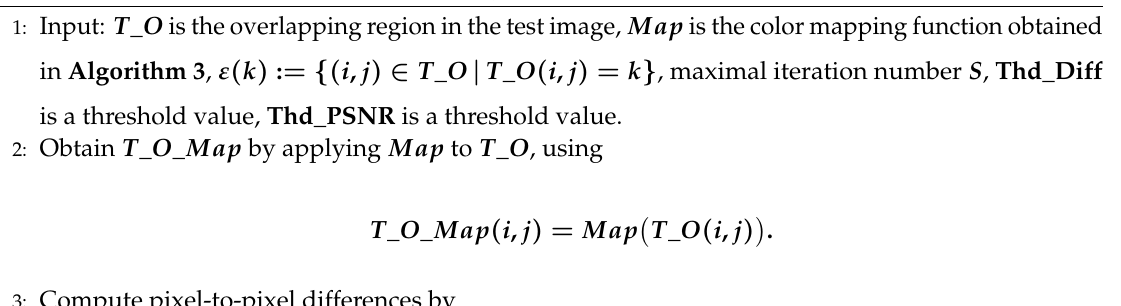
Algorithm 4 Minimize color differences using an iterative